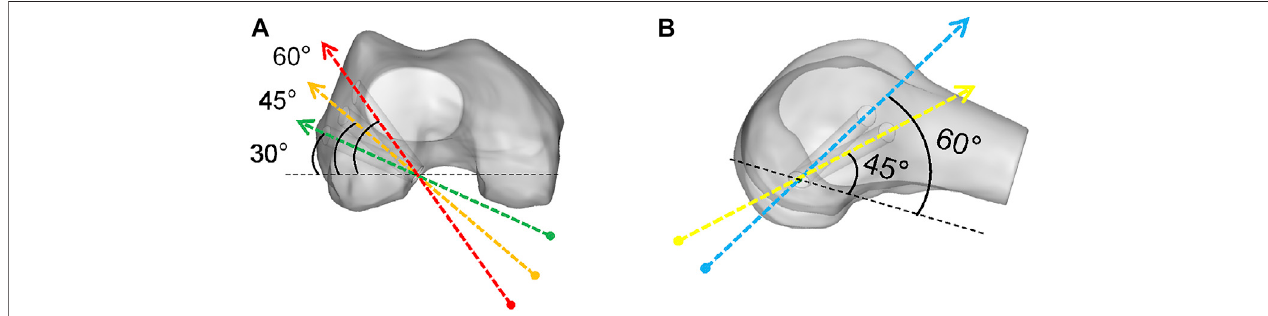
FIGURE 2| Right knee fl exed at 110 ° , demonstratingthe femoraltunnel created by the. anteromedial portal technique at (A) a coronal obliquity angleof 30 ° (green arrow), 45 ° (orange arrow) and 60 ° (red arrow), (B) a sagittal obliquity angle of 45 ° (yellow arrow) and 60 ° (blue arrow), starting at the native femoral ACL center (green circle).